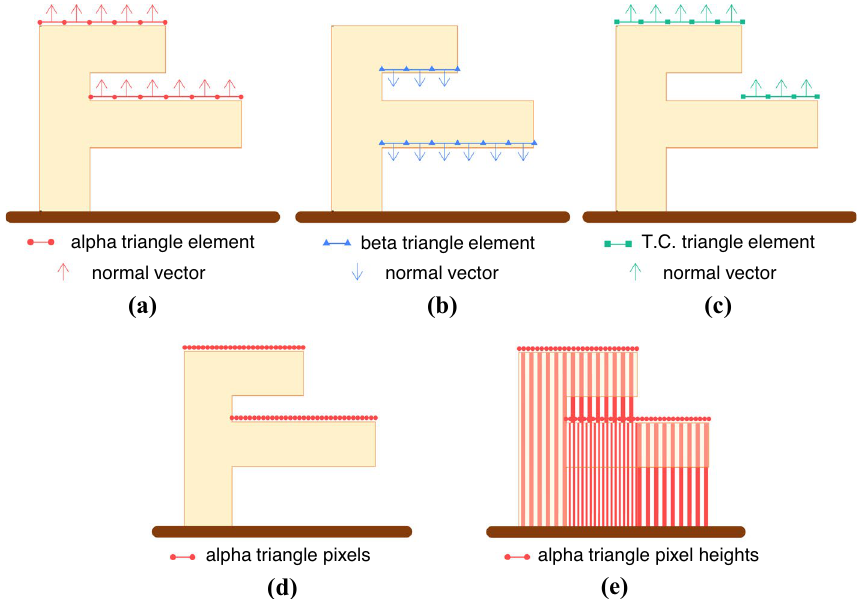
Fig. 2 Signed-shadow casting algorithm overview for a simple “F” character shape (lateral cross-sectional view). a alpha triangle group, b beta triangle group, c TC triangle group triangles, d pixelization of alpha triangles, e integration of angle triangle pixels’ height